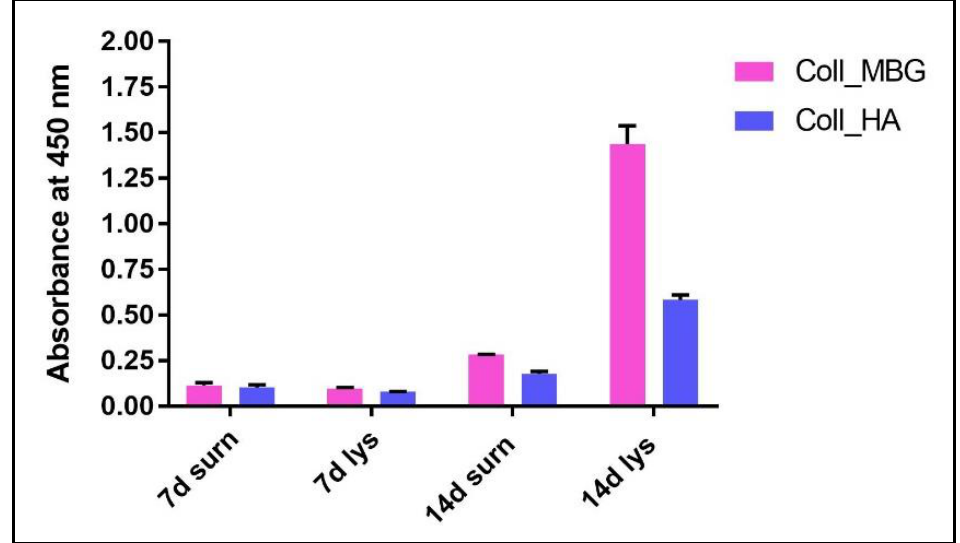
Figure 14. ALP quantification in supernatants and cell lysates of osteoblasts seeded on collagen-based scaffolds with nano-hydroxyapatite (Coll_HA) and collagen-baseds scaffold containing mesoporous bioactive glasses